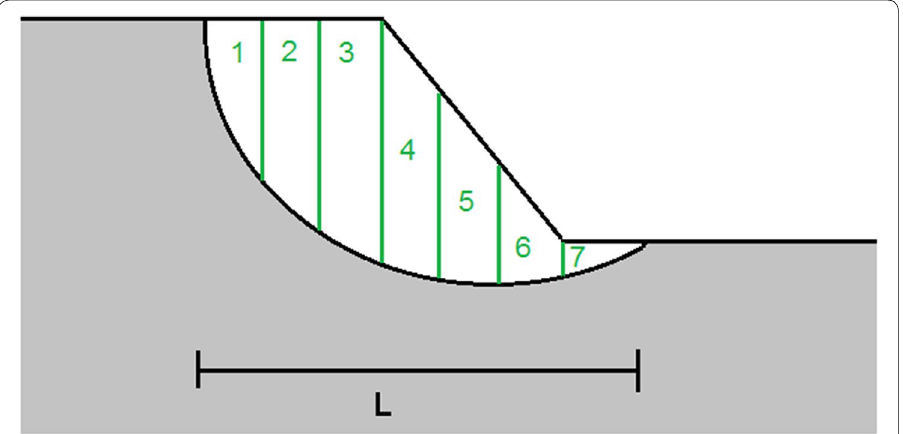
Fig. 4 2D slip circle with seven vertical elements. The length, L, of the slide is defined on the